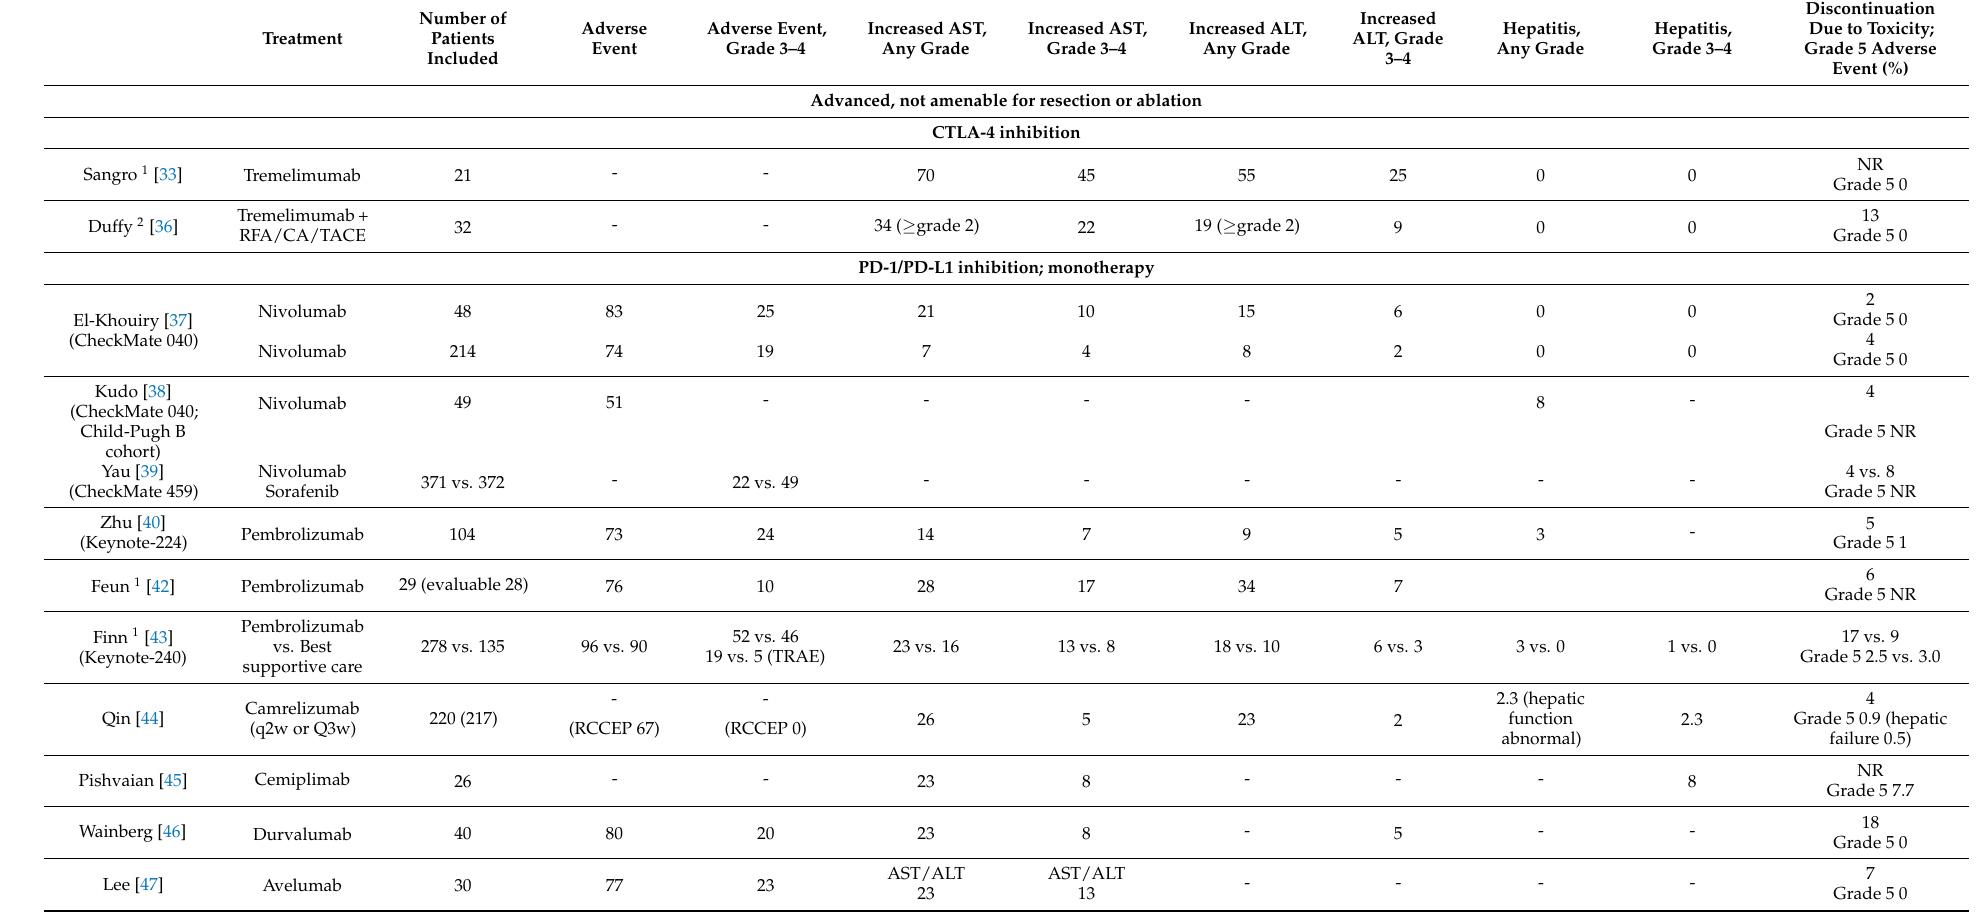
Table 3. Treatment-related overall adverse events and hepatotoxicity of checkpoints inhibitors in